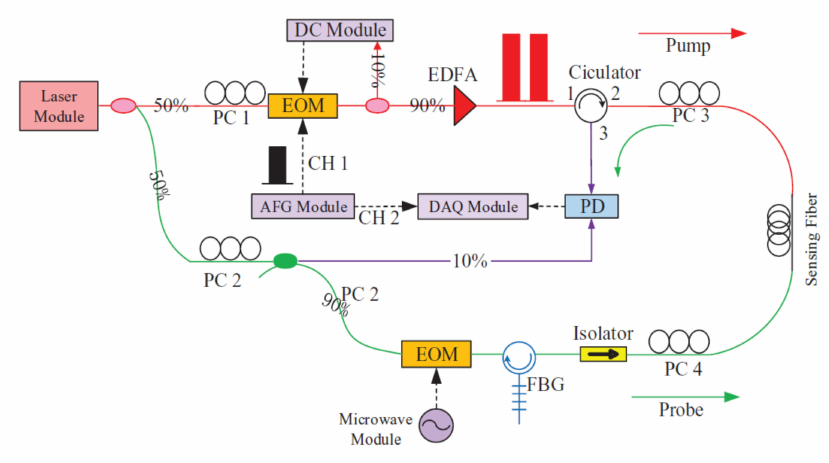
Figure 2. Schematic of the DPP-BOTDA system. PD: photo-detector, PC: polarization controller, EOM: electro-optic modulator, EDFA: Erbium-doped fiber amplifier module, DAQ: data